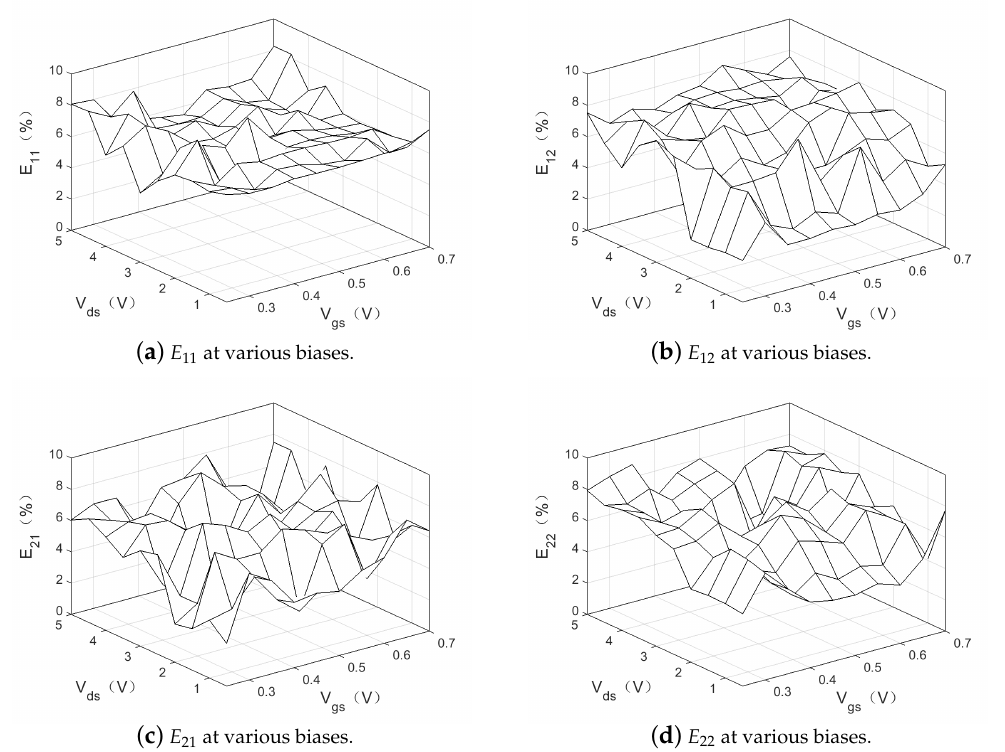
Figure 11. Errors between simulated and measured